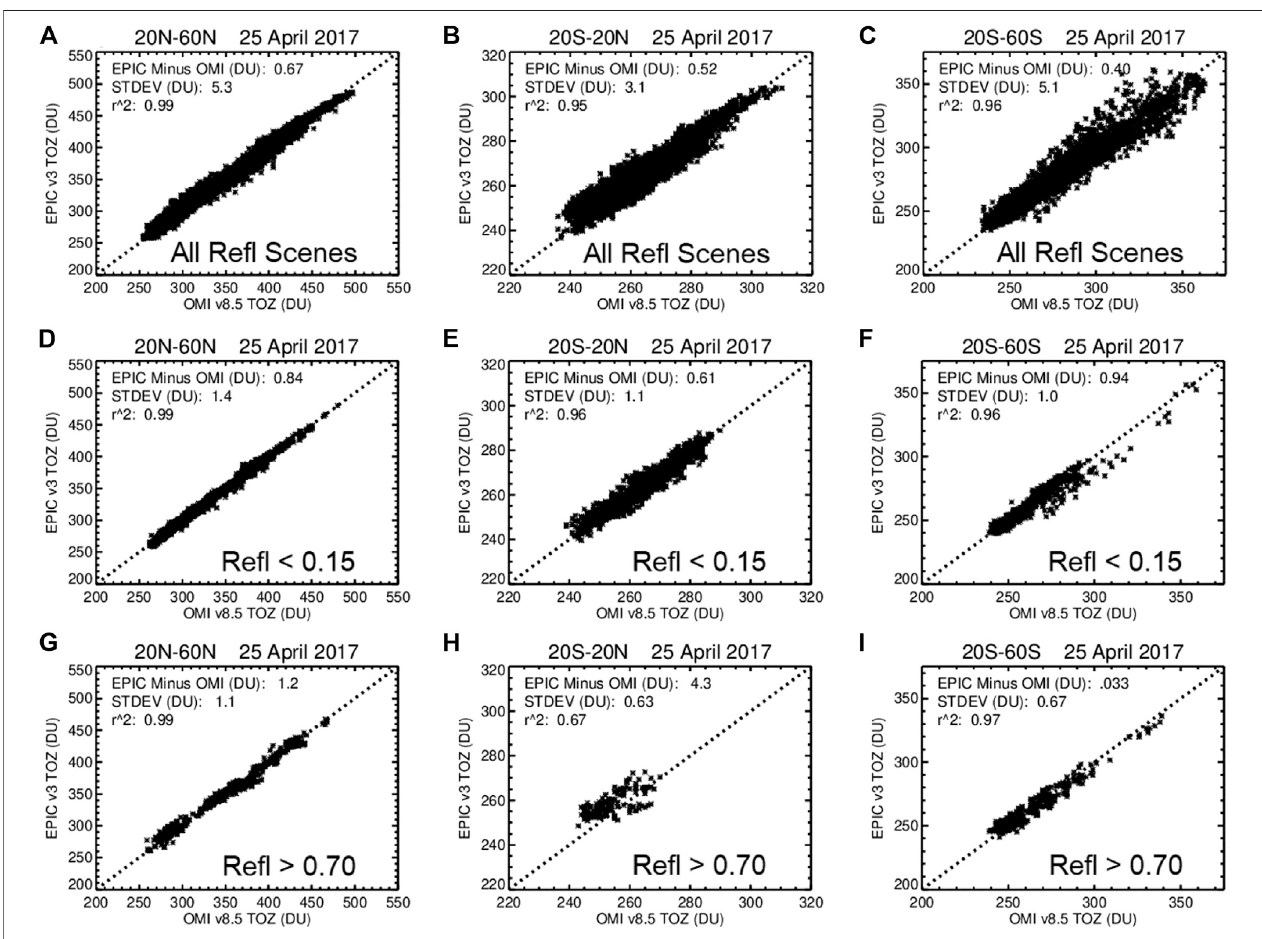
FIGURE 7 | Comparisons between coincident EPIC and OMI TOZ measurements on April 25, 2017 in Dobson Units for all conditions (A – C) , for cases with low scene re fl ectivity R < 0.15 with small cloud fraction and low-altitude clouds (D – F) , and for cases with re fl ectivity values above > 0.7 (G – I) that effectively corresponds to conditionswithhigh-altitudeconvectiveclouds.Thecomparisonsarebinnedin3widelatitudezones:20 ° N-60 ° N(leftcolumn),20 ° S-20 ° N(centercolumn)and20 ° S-60 ° S (right column). The mean differences and standard deviations are shown on each panel.